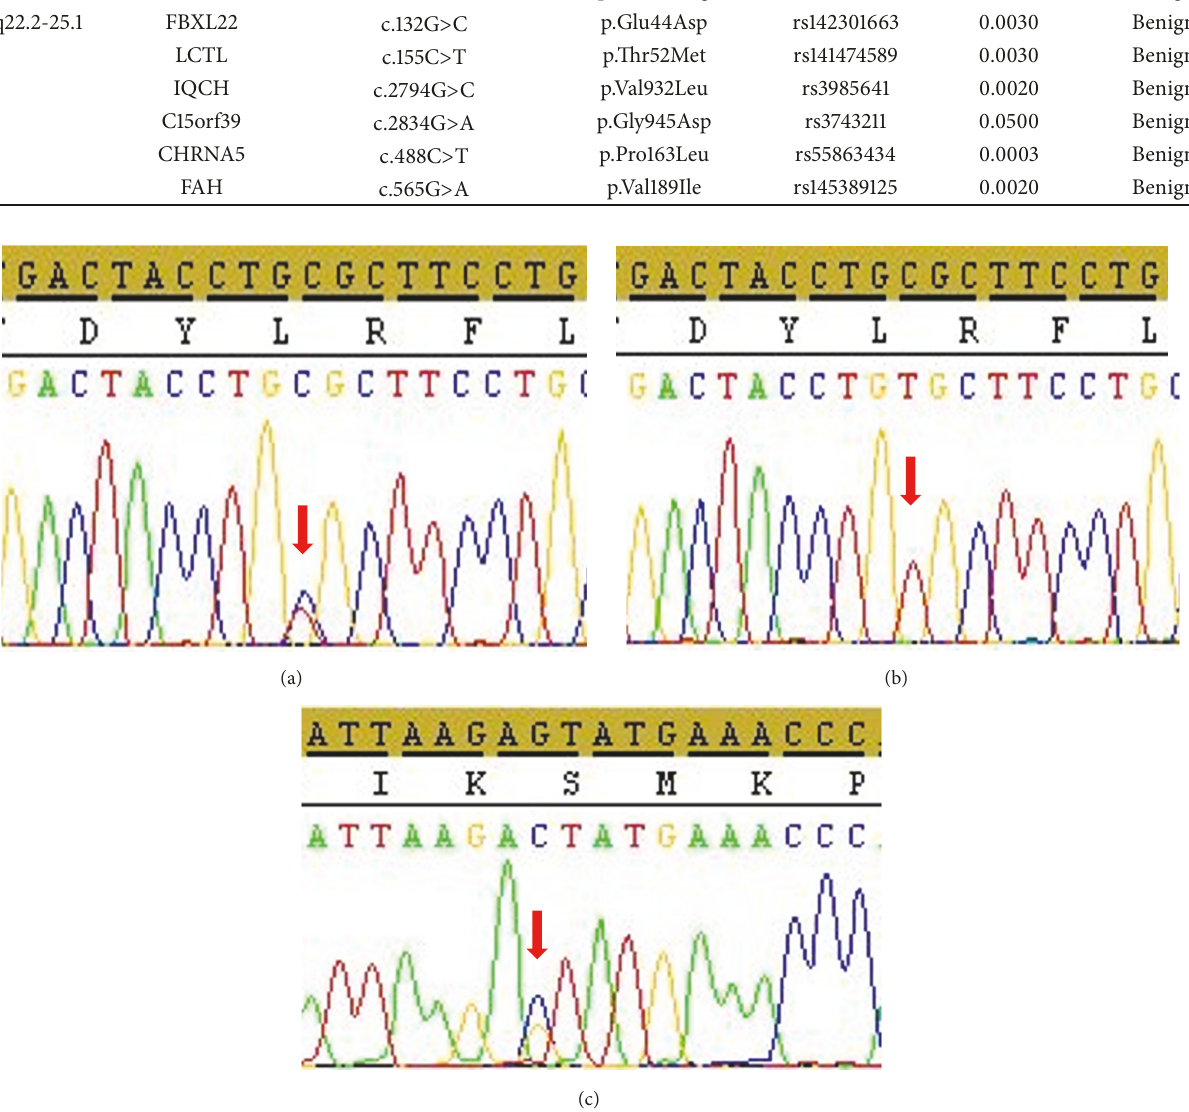
Figure 5: Sanger sequencing plot of GLB1 showing the p.Arg201Cys mutation at heterozygous statein the fatherIV.1, the mother IV.2, and her sister IV.3 (a) and at homozygous state in patients V.1, V.2, and V.3 (b). EXOSC8 p.Ser272Thr mutation at heterozygous state found in